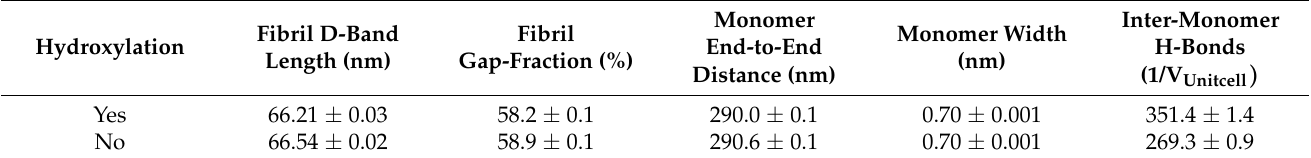
Table 1. Effect of hydroxylation on structural properties of fibrils. Standard deviations are obtained using block averaging. Monomer Fibril D-Band Fibril Hydroxylation Length (nm) Gap-Fraction (%) Distance (nm) Yes 66.21 ± 0.03